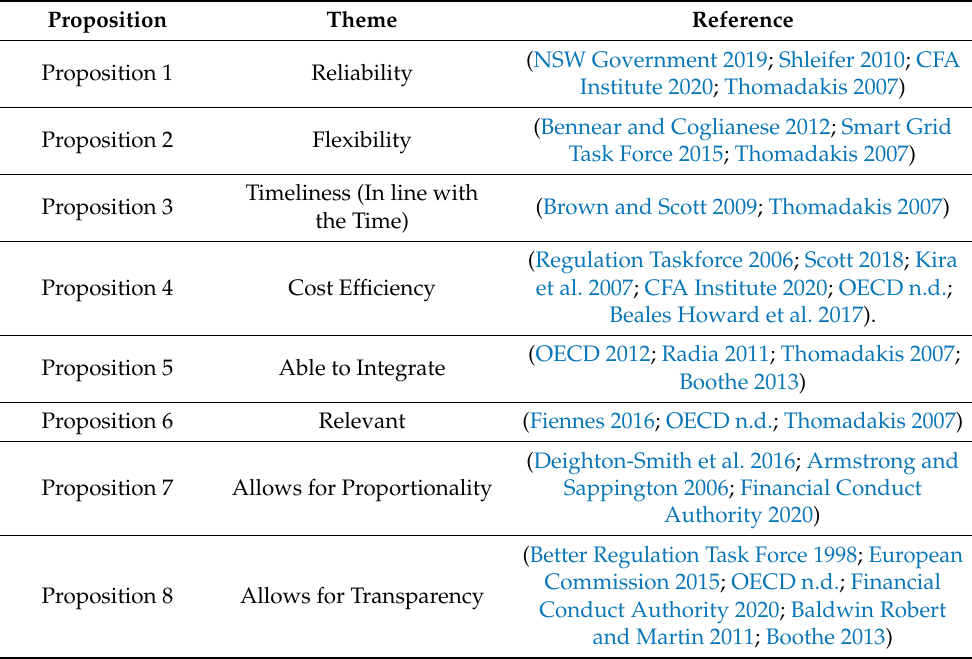
Table 1. Characteristics of good and effective